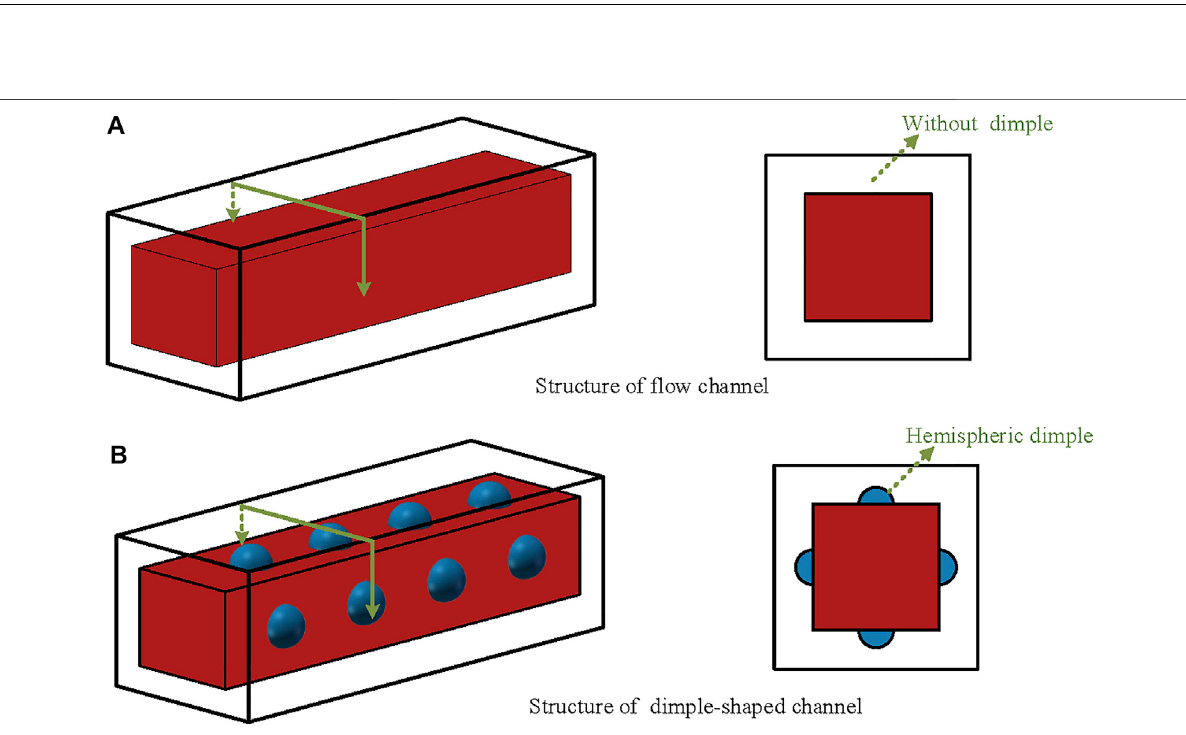
Frontiers in Energy Research |